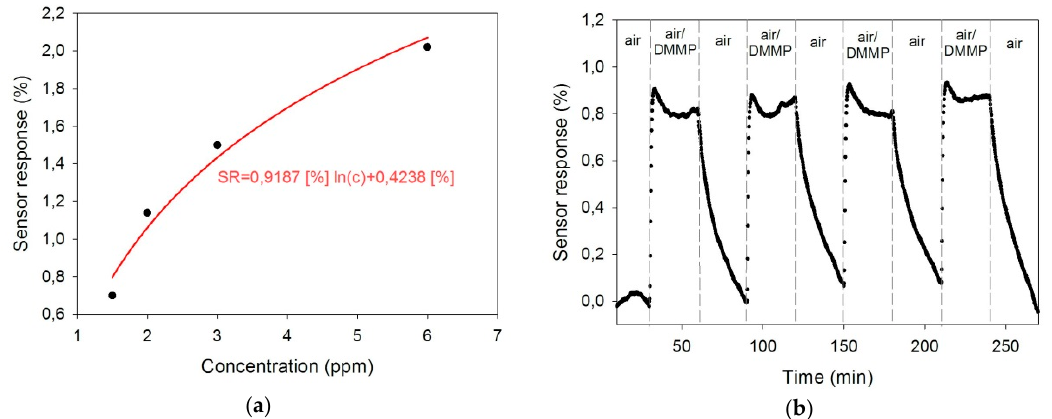
Figure 2. ( a ) Dependence of the sensor response (SR) on the DMMP concentration ( c ), ( b ) Sensor response to the constant concentration (2 ppm) of DMMP.